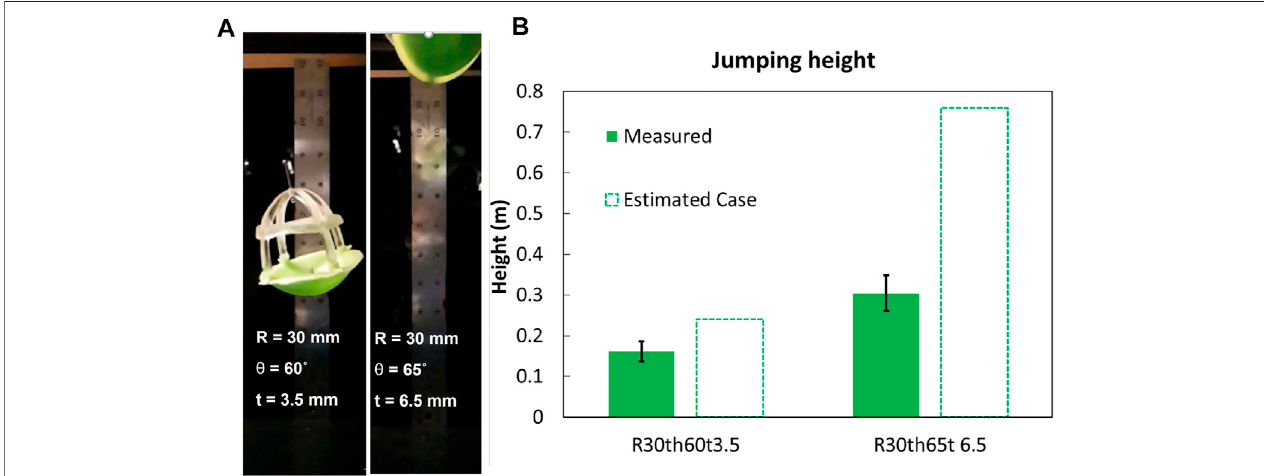
FIGURE5| Validationofmodelofjumpheightasafunctionofelasticshellparameters. (A) Stillsfromahigh-speedvideoofthemaximumjumpheightofthedevices used to validate the impact ofvarying the parameters of the elastic shells. (B) Comparison between the performanceof deviceswith shells with different geometries and their estimated case, and measured height in three trials.